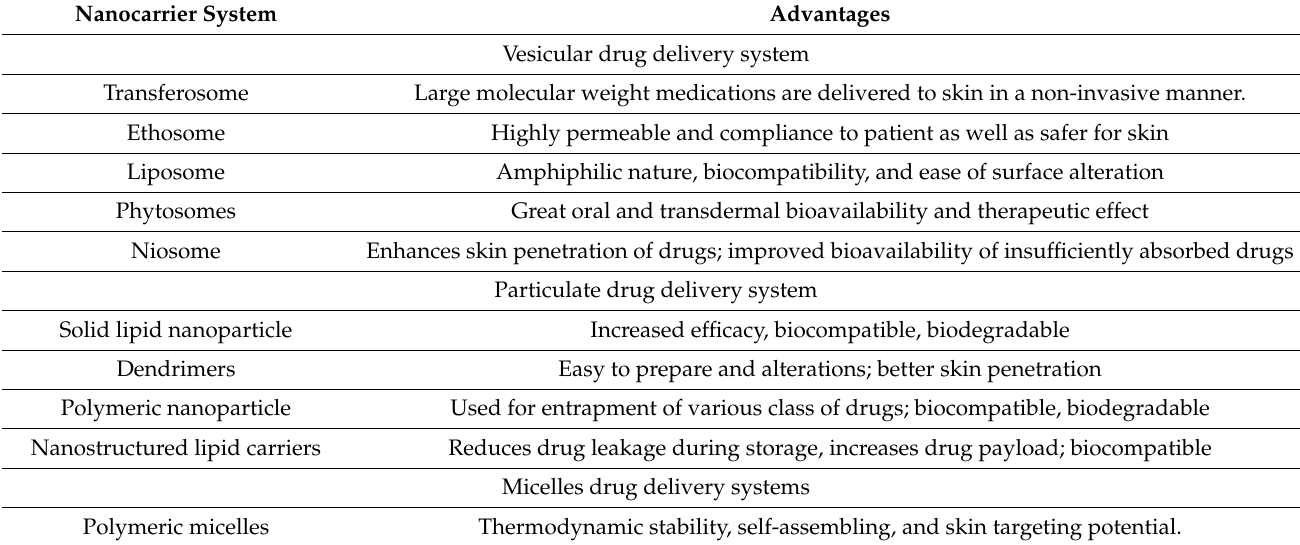
Table 3. Advantages of colloidal drug delivery systems for topical drug delivery for psoriasis treatment.